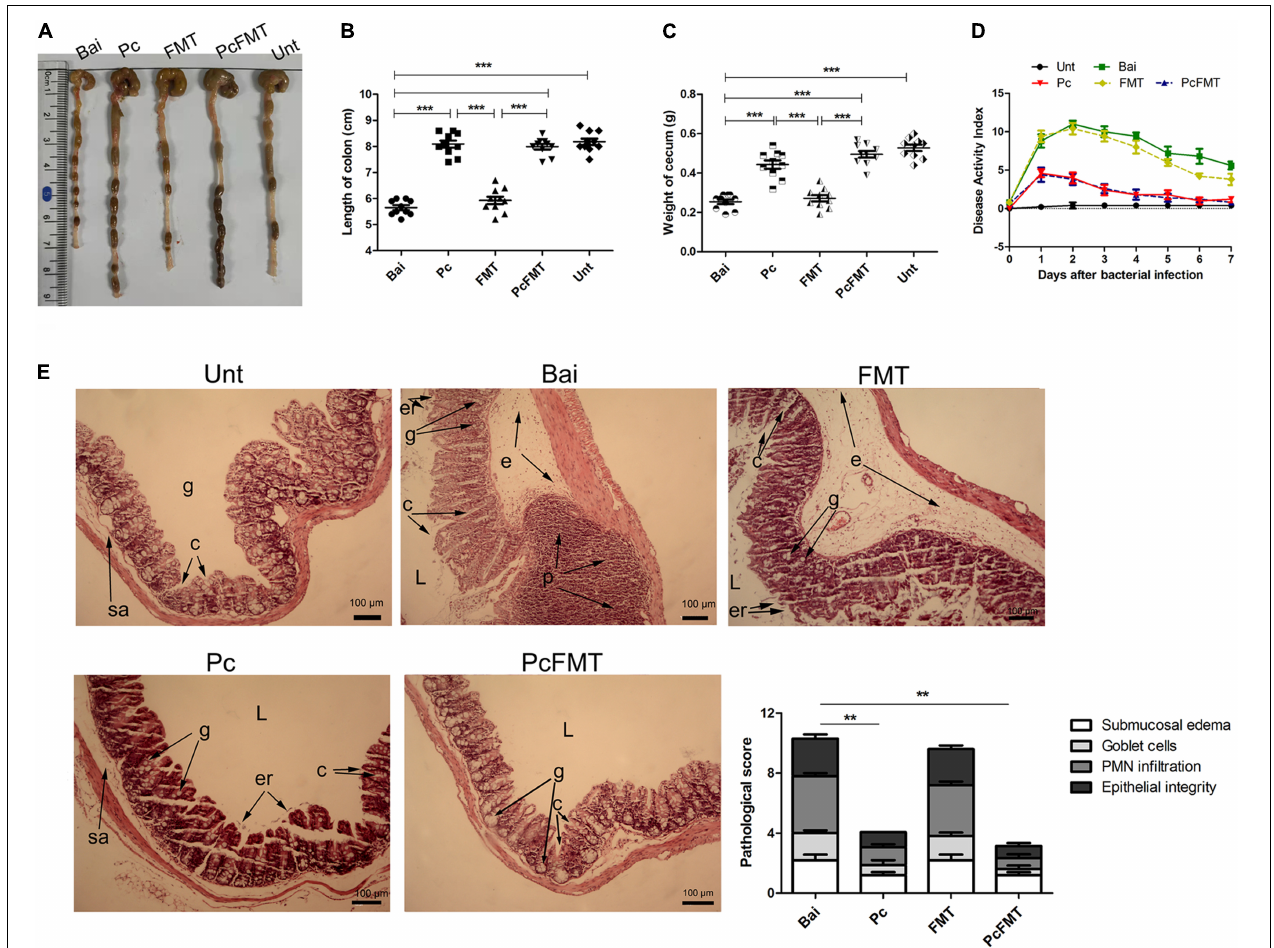
FIGURE 4 | PcFMT treatment effectively improved mouse colitis caused by S. typhimurium . The colonic tissues were collected from healthy, bacterial-infected, single-dose Pc-treated, FMT-treated, and PcFMT-treated mice 48 h after S. Typhimurium (0.2 mL, 4 × 10 8 CFU/mouse) infection. “Unt” represents untreated healthy mice group; “Bai” represents the bacterial-infected mice group; “Pc” means phage cocktail-treated mice group; “PcFMT” represents the combined phage cocktail and FMT mice group. (A) Macroscopic pathological changes in the colon and caecum. The length of the colon (B) and the weight of the caecum (C) (n = 6) from untreated, bacterially infected, single-dose Pc-treated, FMT-treated, and PcFMT-treated mice were measured at 48 h post-infection. (D) Disease activity index (DAI). (E) H&E staining. Colonic tissue was stained with H&E (100 × ). L, intestinal lumen; e, edema; p, PMN; er, erosion of the epithelial layer; c, crypt; g, goblet cell; sa, submucosa. Magnifications are indicated by the black bars. Data are expressed as the means ± SEM, n = 6. ** P < 0.01; *** P <